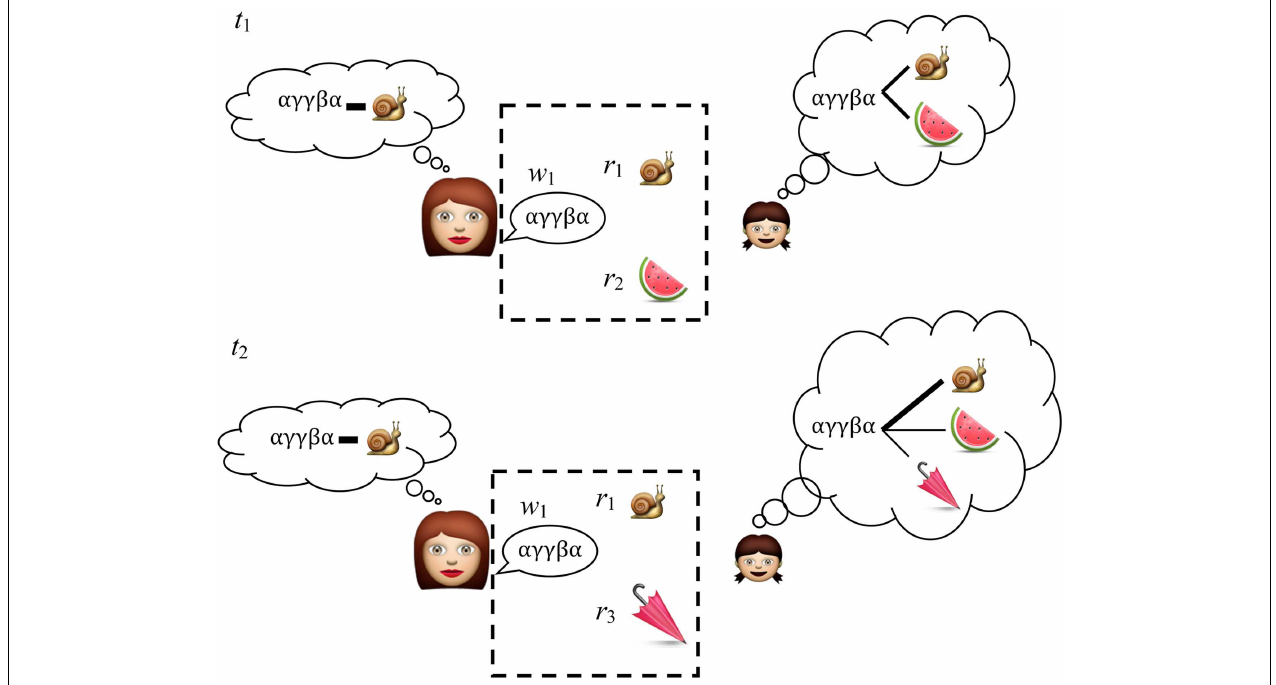
FIGURE 3 |An adult chooses a linguistic expression w 1 associated with concept r 1 that they want to communicate. At t 1 the child doesn’t know whether the novel word w 1 refers to r 1 or r 2 and for now the best she can do is remember the associations between the scene and the words. At t 2 she hears w 1 with one object r 1 familiar from t 1 and one new object r 3